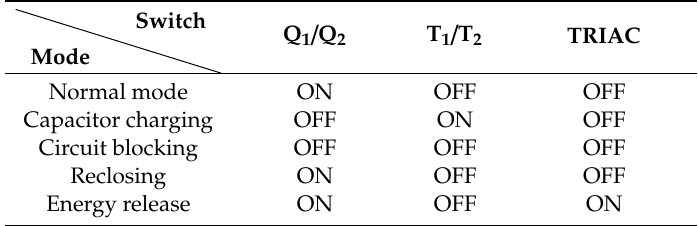
Table 1. Switching state of each mode.